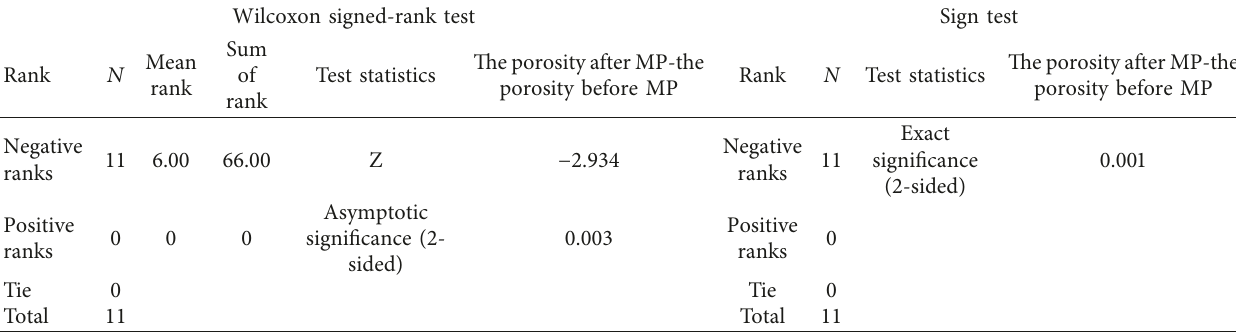
Table 6: Analytical results of the paired sample test.